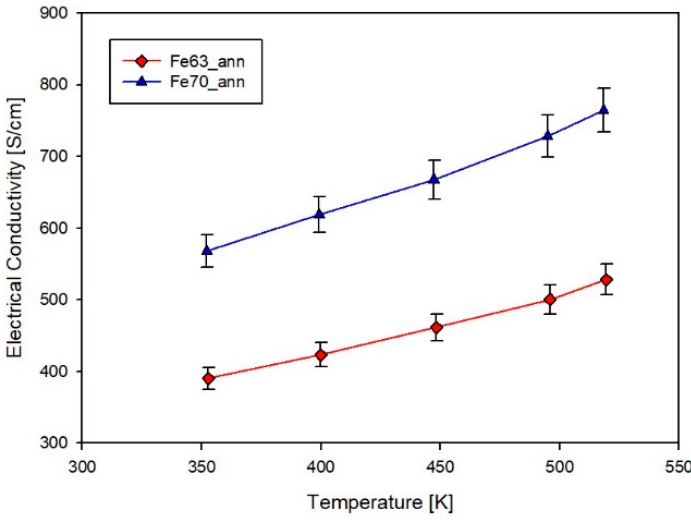
Figure 10. Trend of the last cycle of the electrical conductivity as a function of temperature for samples Fe63_ann and